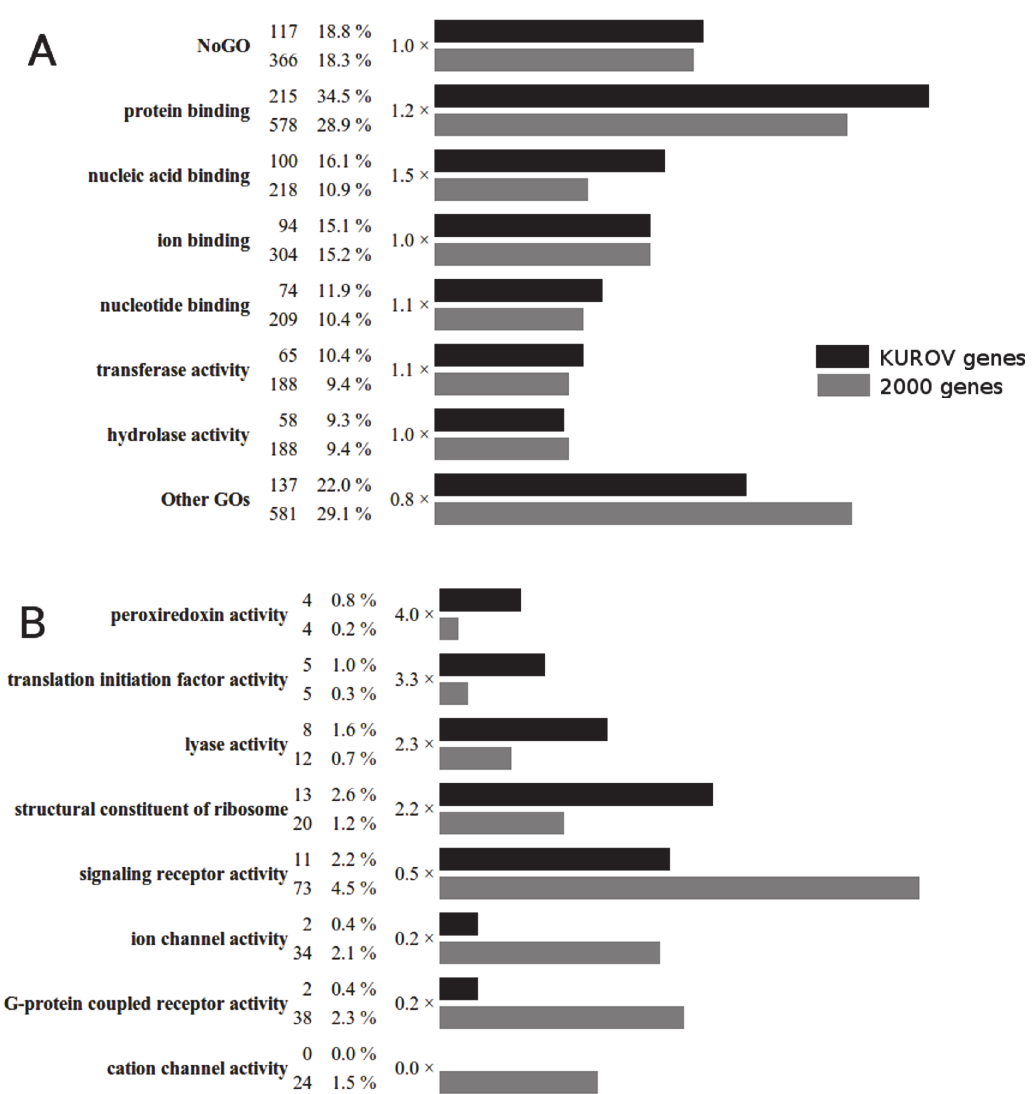
Fig 5. Comparison of the ‘ Molecular Function ’ GO term distributions for the 623 KUROV (black) and 2000 (gray) genes. A: Most populated GO terms. After each GO term, the total number of genes verifying a given GO term among the 623 KUROV genes and the 2000 annotated genes are indicated followed by their corresponding percentages and the ratio of these percentages. For sake of clarity, only GO terms present in more than 7% of the respective gene sets are shown. NoGO: genes with no assigned GO term. Other GOs: sum of all other categories. B: Biologically relevant GO terms exhibiting over- or under- representation using the highest and lowest percentage